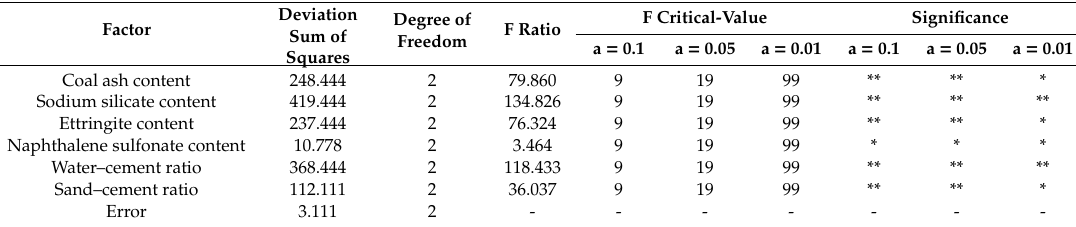
Table 9. Analysis of variance of adhesion stress in the orthogonal